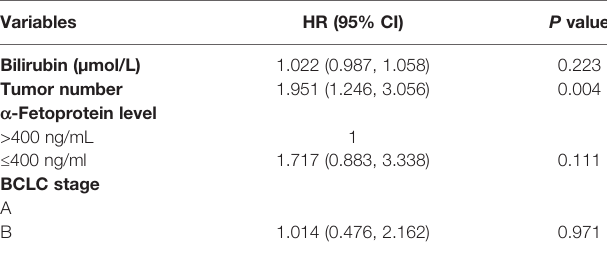
TABLE 4 | Multivariate analysis of prognostic factors for time to progression.